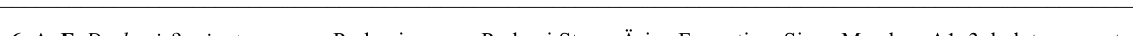
Fig. 6. A(cid:150)F , Drabovia ? minuta sp. nov. Porkuni quarry, Porkuni Stage, ˜rina Formation, Siuge Member. A1(cid:150)3, holotype, ventral valve GIT 626-28, exterior, interior and lateral views. B1(cid:150)3, ventral valve GIT 626-38, interior view and tilted views of muscle field and area. C1(cid:150)4, dorsal valve GIT 626-32, exterior, interior and tilted views of interior. D1(cid:150)3, dorsal valve GIT 626-35, exterior and interior views, and view of cardinalia. E1, 2, dorsal valve GIT 626-33, exterior and interior views. F1, 2, ventral valve GIT 626-29, interior and exterior